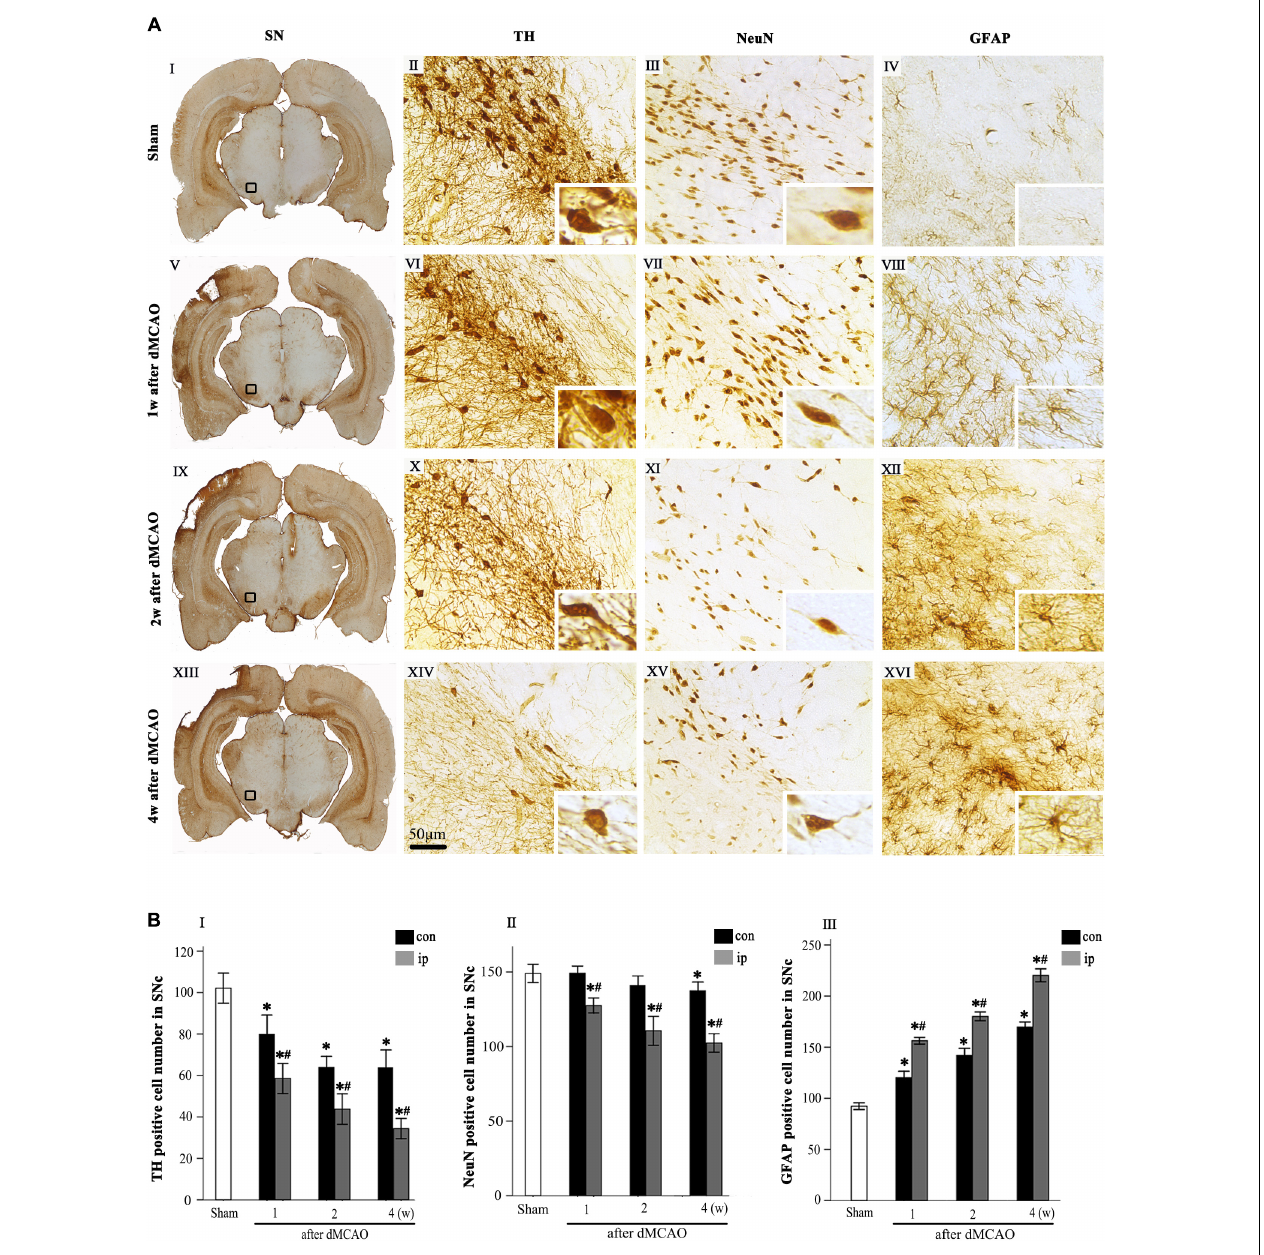
FIGURE 1 | Secondary degeneration in the ipsilateral SN after dMCAO in rats. (A) Representative microphotographs of immunohistochemistry for TH (II,VI,X,XIV) , NeuN (III,VII,XI,XV) and GFAP (IV,VIII,XII,XVI) in SNc at 1 week (V–VIII) , 2 weeks (IX–XII) , and 4 weeks (XIII–XVI) after dMCAO and sham-operated groups (I–IV) . The pictures on the right are magnified from the square area on the left. Scale bar, 50 µ m. (B) Quantitative analyses of TH + (I) , NeuN + (II) , and GFAP + (III) cells in the SNc at 1, 2, and 4 weeks after dMCAO. Quantitative analyses showed that dMCAO decreased the number of TH + cells in the ipsilateral [ F ( 3 , 101 ) = 94.59, p < 0.01] and contralateral SNc [ F ( 3 , 101 ) = 25.78, p < 0.01], and NeuN + cells in the ipsilateral SNc [ F ( 3 , 83 ) = 38.19, p < 0.01], and increased the number of GFAP + cells in the ipsilateral SNc [ F ( 3 , 122 ) = 638.85, p < 0.01] at 1, 2, and 4 weeks. Each bar represents the mean ± SD ( n = 6 in each group). ∗ p < 0.05 vs. sham-operated group; # p < 0.05 vs. contralateral groups at the same time point. SN, substantia nigra; SNc, substantia nigra compact part; TH, tyrosine hydroxylase; NeuN, neuron-specific nuclear-binding protein; GFAP, glial fibrillary acidic protein; Sham, sham-operated; w, week; dMCAO, distal middle cerebral artery